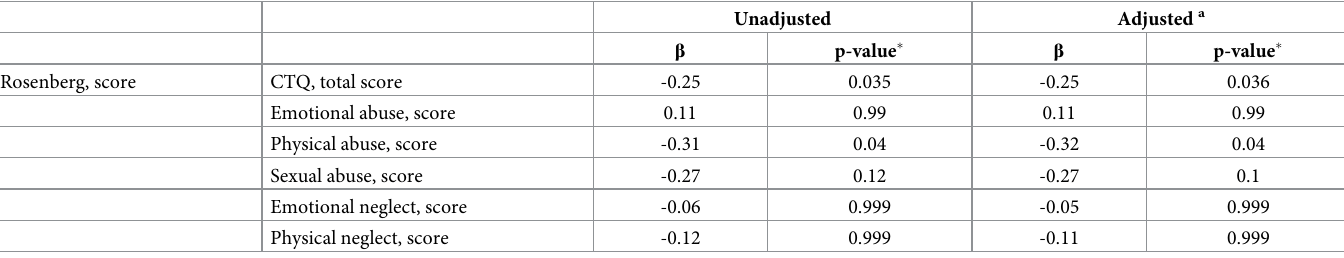
Table 5. Association between self-esteem and childhood trauma at